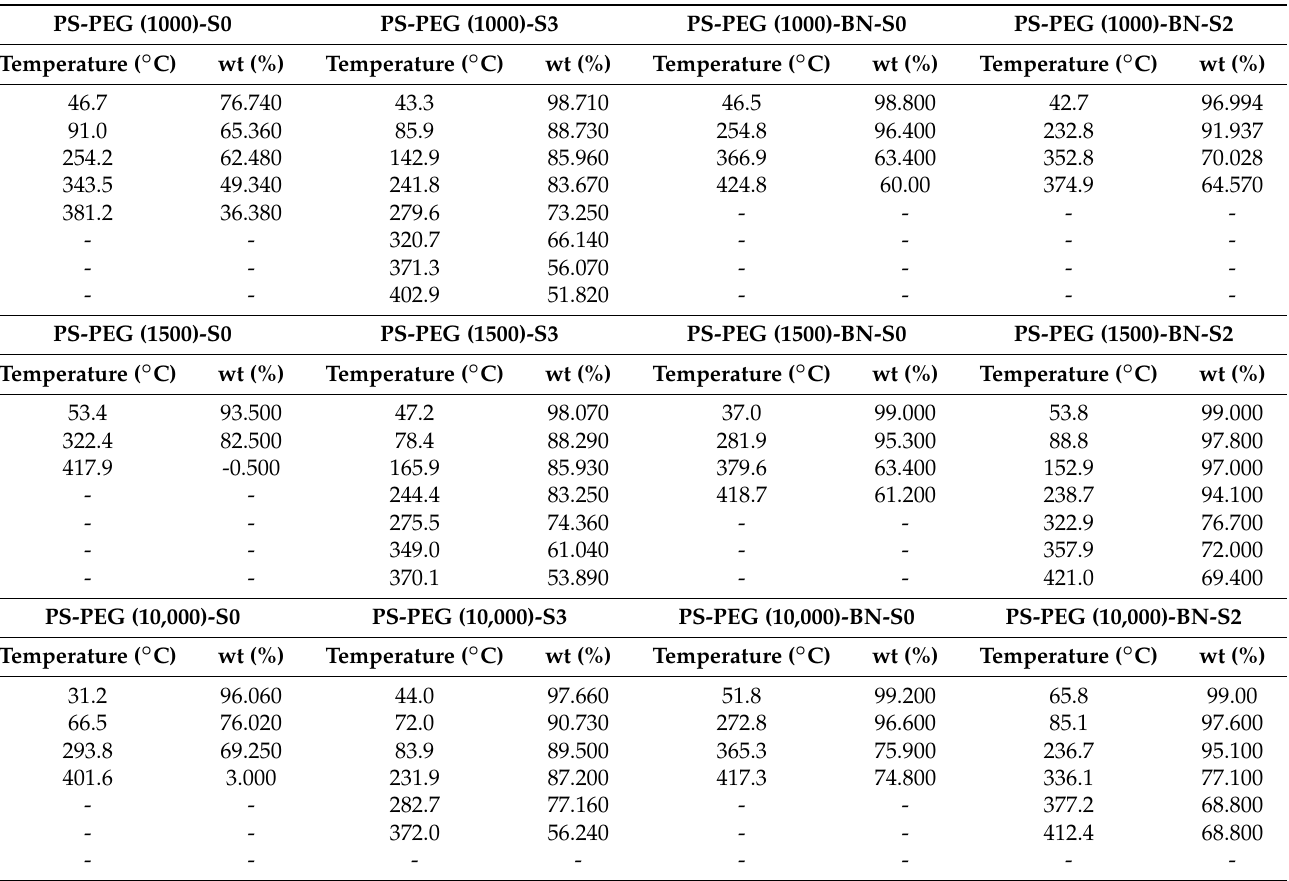
Table 2. TGA thermogram values of the PbO doped the crosslinked PS-b-PEG block copolymer and the PS-b-PEG-BN nanocomposite